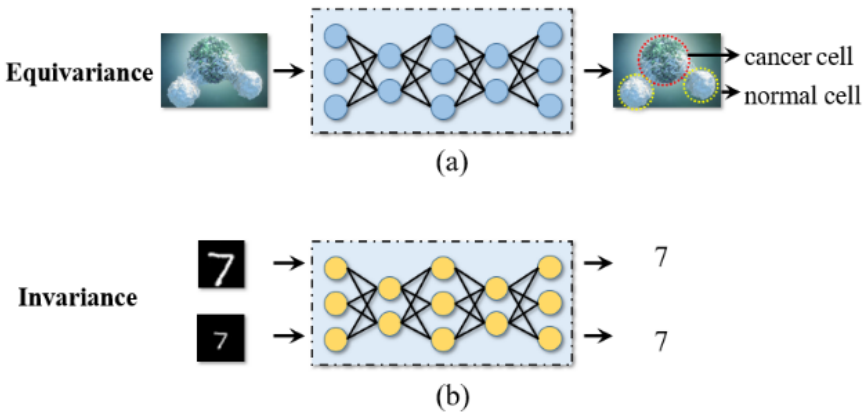
Figure 1. Difference between equivariance and invariance. ( a ) equivariance and ( b ) invariance. Scale variation is as common as translation, whereby the existing CNN adopts both a sliding-window convolution and pooling in order to adapt to the scale change, but its scale equivariance is poor [10]. For example, after the input image is scaled, the learned convolution kernel will mismatch the scaled images, as shown in Figure 2, resulting in weak equivariance for scaling.